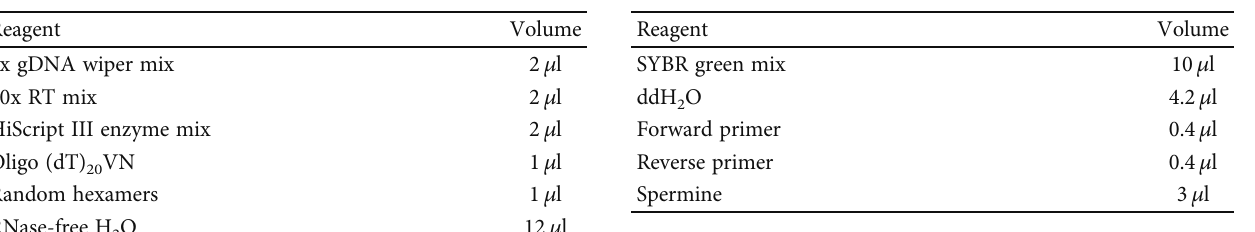
Table 2: cDNA synthesis system. Table 3: QRT-PCR reaction